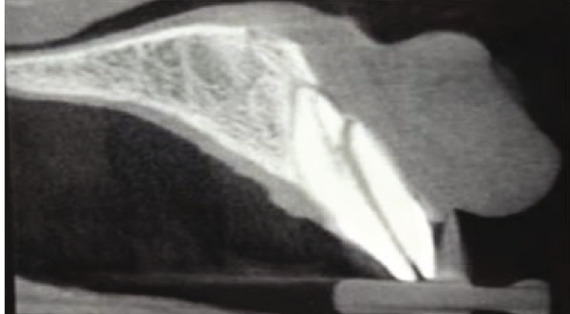
Figure 2: Preop CBCT.